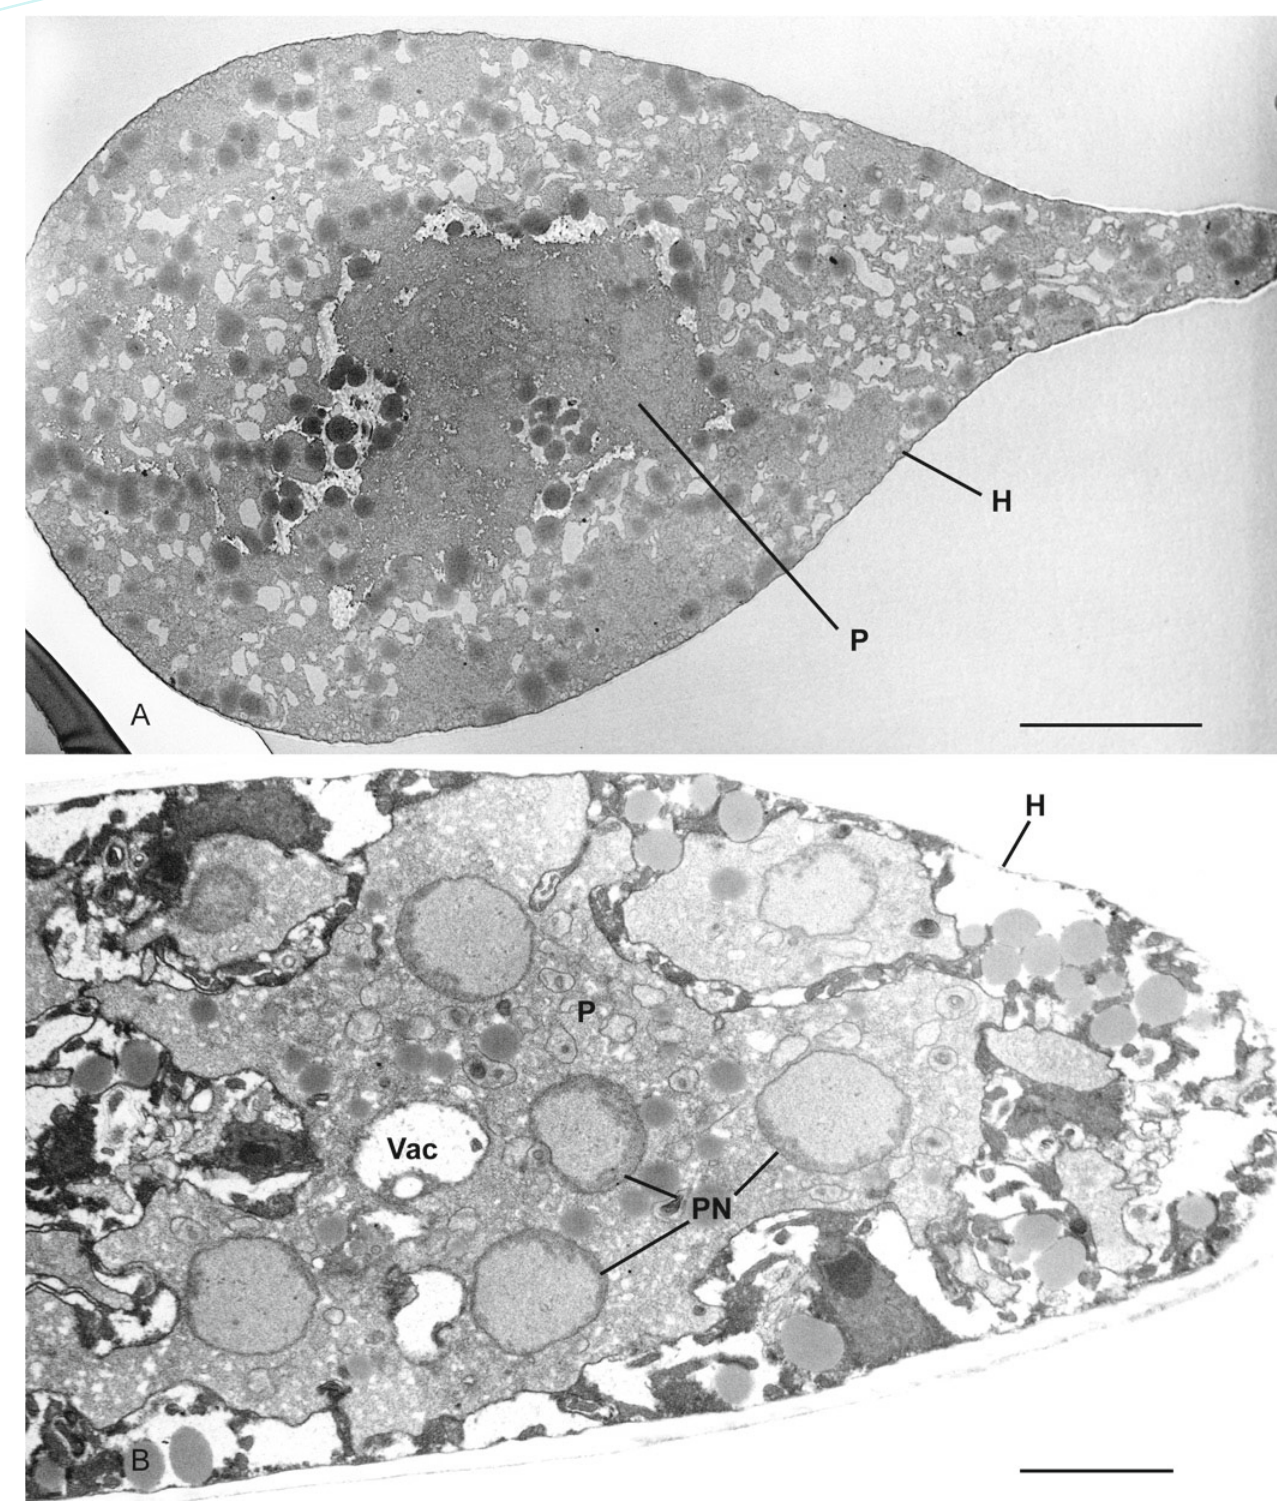
Fig. 3. Plasmodial development in Rozella . A. Early plasmodial formation of R. multimorpha [strain JEL 883; Letcher et al . 2018] in host Pythium catenulatum . B. Multinucleate plasmodium of R. allomycetis [strain CSF 55; Powell et al . 2017] in host Allomyces arbuscula ; plasmodium has a (cid:19)(cid:13)(cid:17)(cid:8)(cid:10)(cid:9)(cid:23)(cid:2)%(cid:9)(cid:19)(cid:5)(cid:4)(cid:23)(cid:13)(cid:28)(cid:2)U(cid:12)(cid:12)(cid:10)(cid:13)%(cid:11)(cid:9)(cid:8)(cid:11)(cid:4)(cid:17)(cid:7)$(cid:2)\(cid:29)(cid:2)(cid:14)(cid:4)(cid:7)(cid:8)(cid:30)(cid:2)(cid:133)(cid:29)(cid:2)(cid:18)(cid:9)(cid:10)(cid:9)(cid:7)(cid:11)(cid:8)(cid:13)(cid:2)(cid:18)(cid:23)(cid:9)(cid:7)(cid:6)(cid:4)(cid:21)(cid:11)(cid:5)(cid:6)(cid:30)(cid:2)(cid:133)<(cid:29)(cid:2)(cid:18)(cid:9)(cid:10)(cid:9)(cid:7)(cid:11)(cid:8)(cid:13)(cid:2)(cid:17)(cid:5)(cid:19)(cid:23)(cid:13)(cid:5)(cid:7)(cid:30)(cid:2)(cid:154)(cid:9)(cid:19)(cid:29)(cid:2)%(cid:9)(cid:19)(cid:5)(cid:4)(cid:23)(cid:13)(cid:28)(cid:2)O(cid:9)(cid:10)(cid:7)(cid:2)(cid:149)(cid:2)_(cid:2)(cid:128)(cid:6)(cid:28)